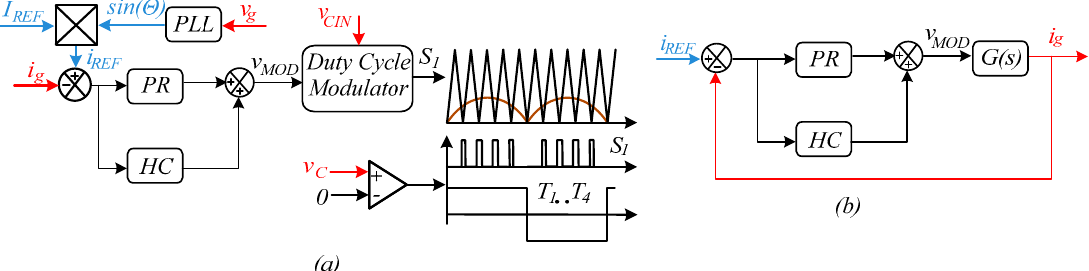
Figure 3. Control system structure for the proposed solution ( a ) and closed-loop control equivalent circuit ( b ).